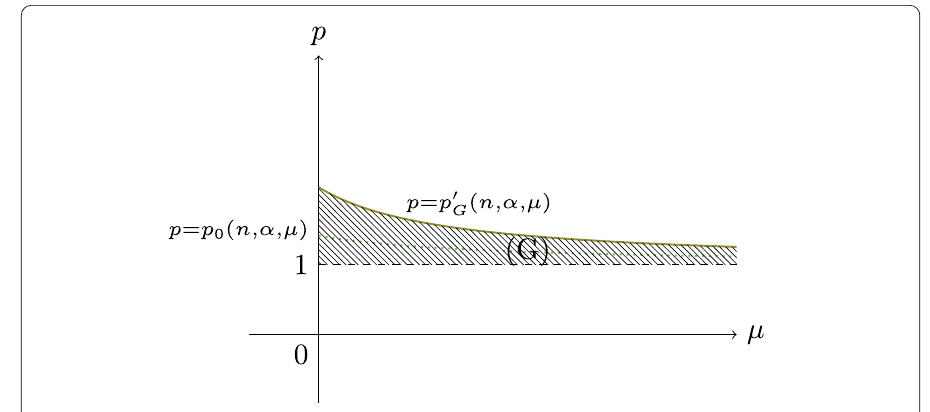
Figure 1 Range of blow-up conditions in case n = 3 and α = 0.2